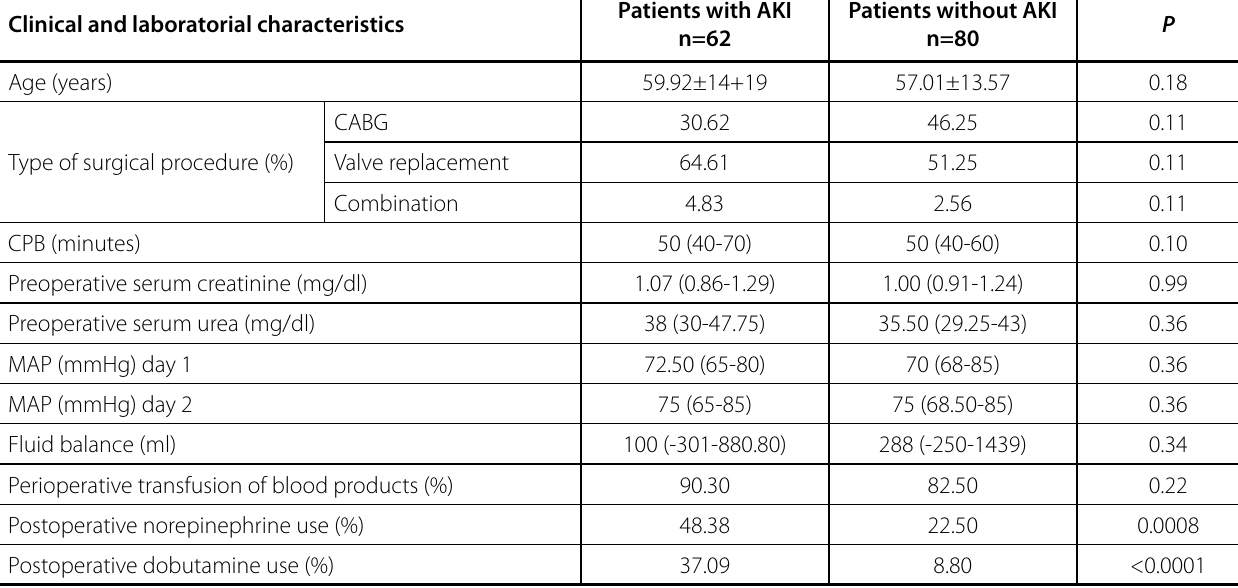
Table 2 . Clinical and laboratorial differences between patients with and without acute kidney injury (AKI). Clinical and laboratorial